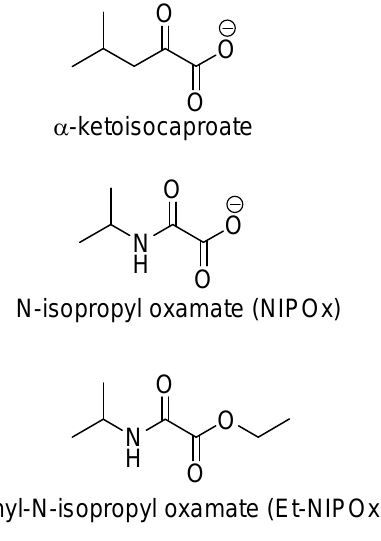
Figure 4. Chemical structures of α -ketoisocaproate, NIPOx and